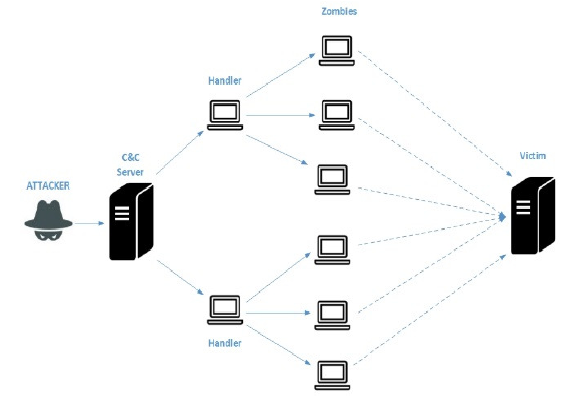
Fig. 2: Typical scenario of DDoS